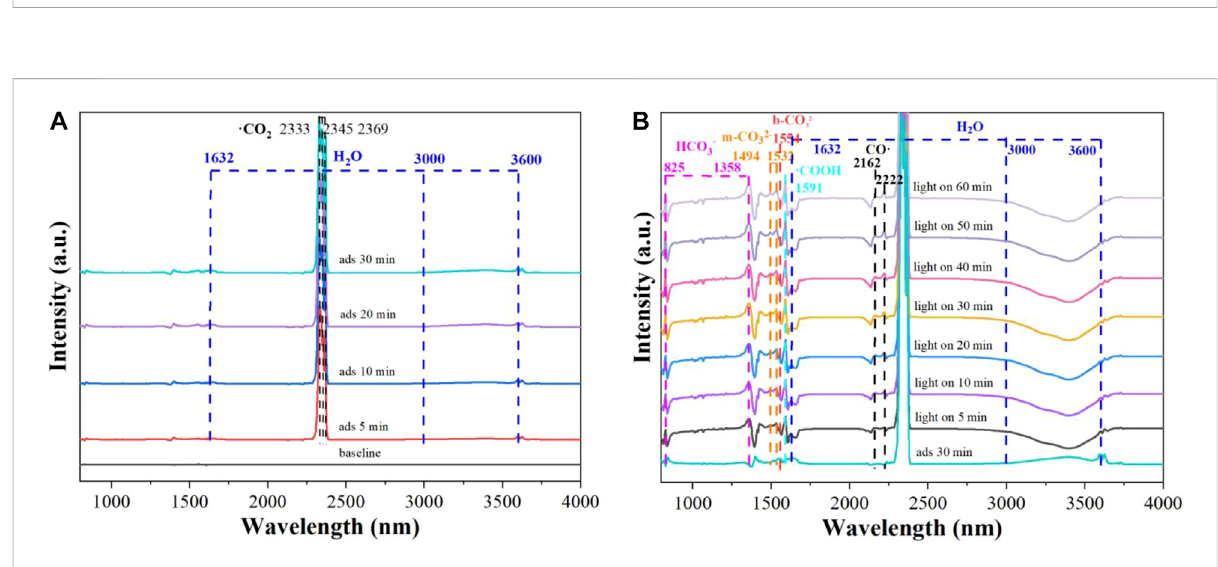
FIGURE 9 (A) In situ DRIFT spectra of CO 2 and H 2 O absorption and (B) reaction on Cu I MOF